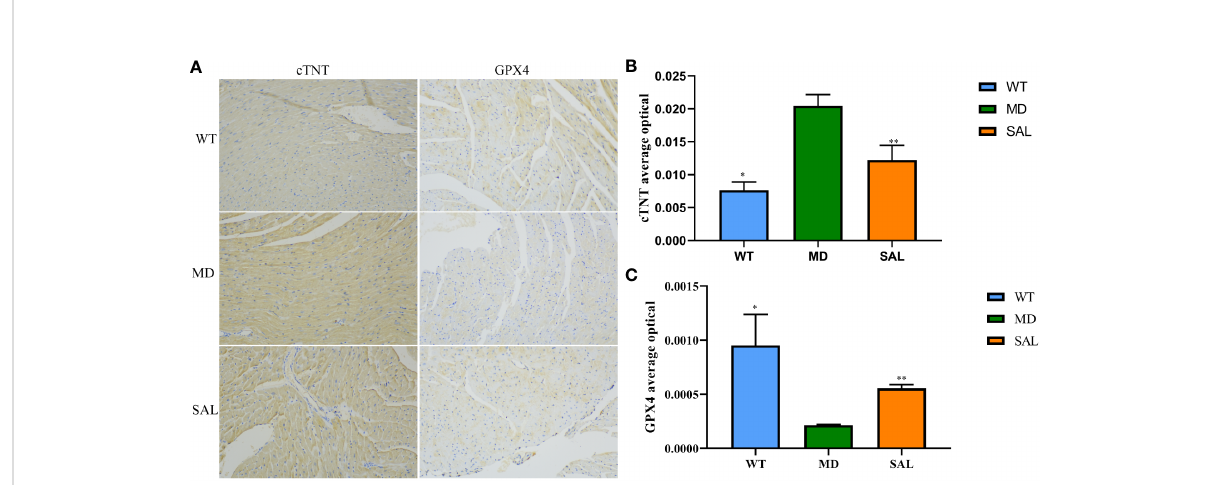
FIGURE 2 In fl uence of SAL on the expression of myocardial injury markers in diabetic mice. (A) , Immunohistochemistry of cTNT and GPX4 in myocardial tissue. (B) , The optical density value (IOD) of the brown colour of cTNT staining in myocardial tissue. (C) , The IOD value of the brown colour of GPX4 staining in myocardial tissue. (ns, no statistical signi fi cance; * p < 0.05 as MD group vs WT group; ** p < 0.05 as MD group vs SAL